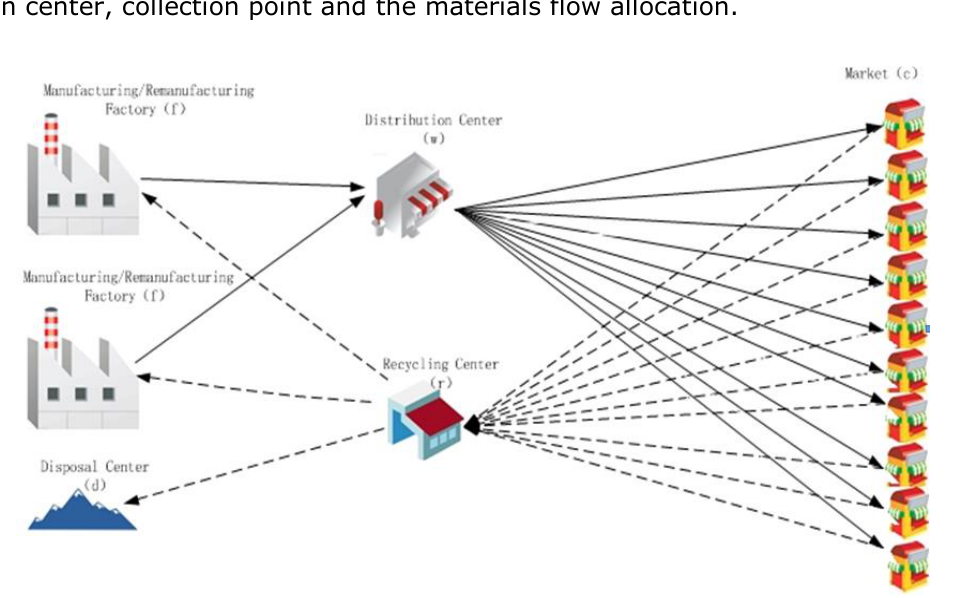
Figure1. Logistics network topology structure of the model